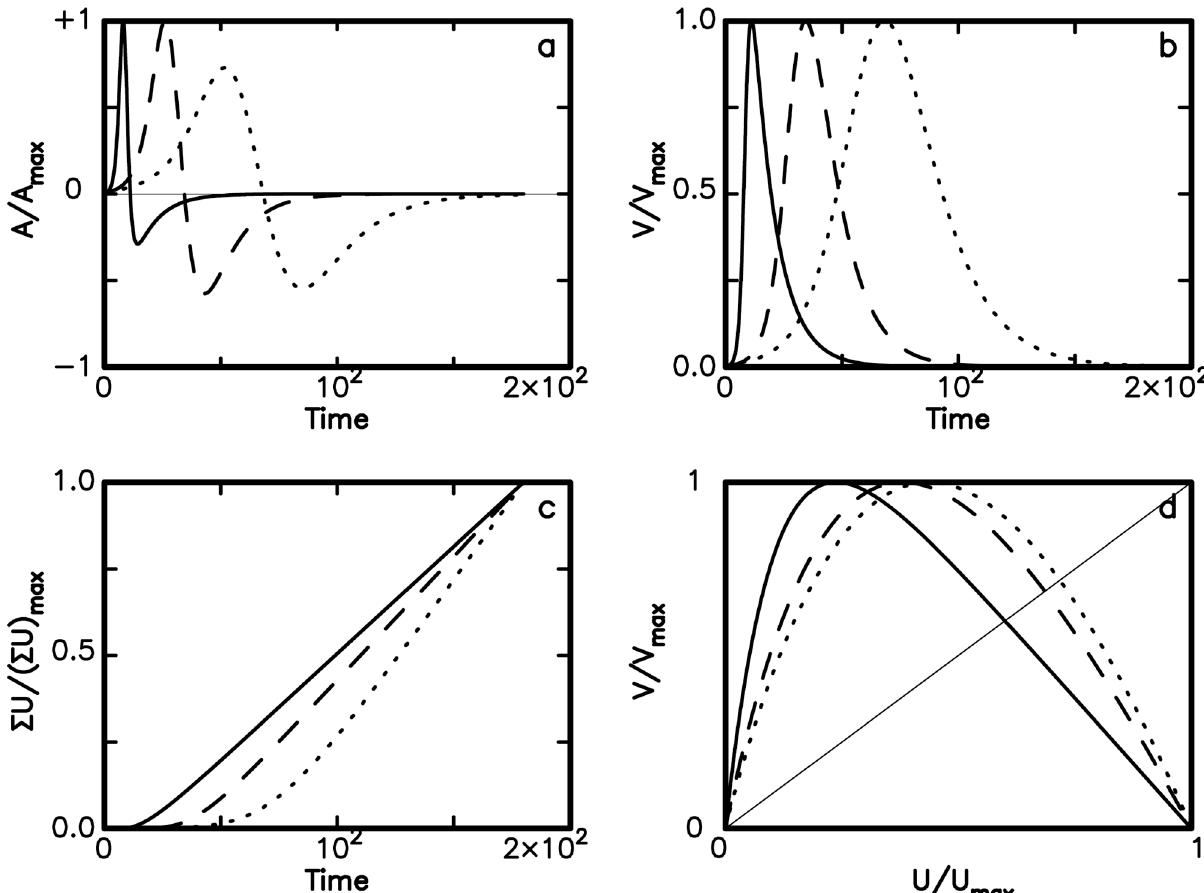
), normalized velocity ( V / V max versus U / U of the slider, acted by SW friction of F ( U )= 1/( U + U max max